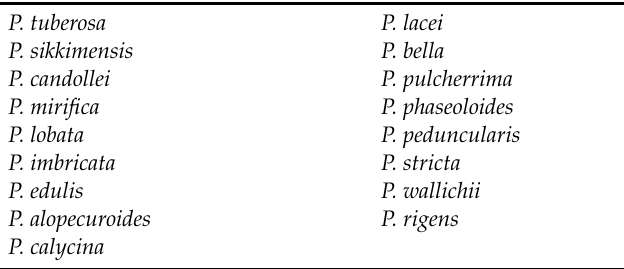
Table 1. Species of Pueraria throughout the world